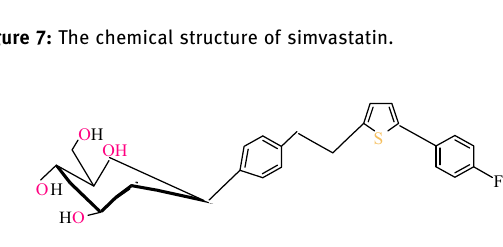
Figure 8: The chemical structure of Canagli fl